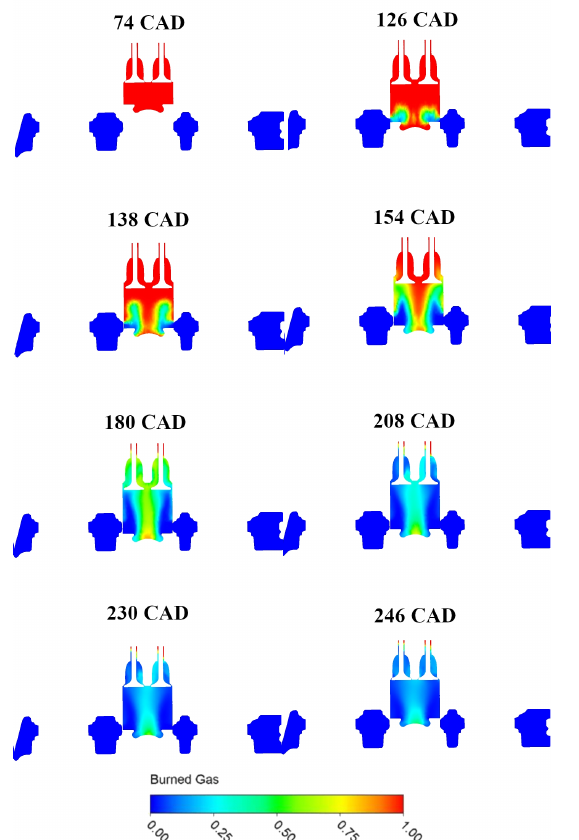
Figure 18. Contour plot of the Burned Gas mass fraction at different time instants for the new